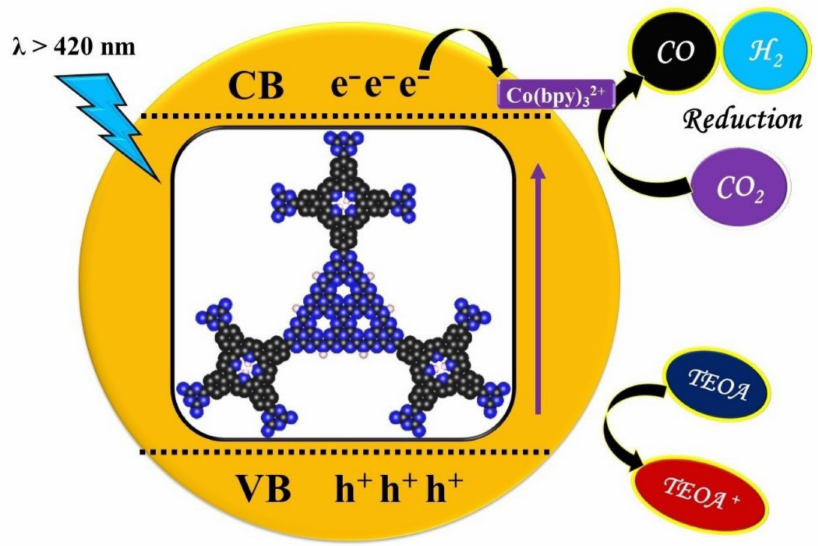
Figure 8. Under visible light irradiation, cobalt redox catalysis and CN-TDP 7.0 photocatalysis work together to activate and reduce CO 2 to